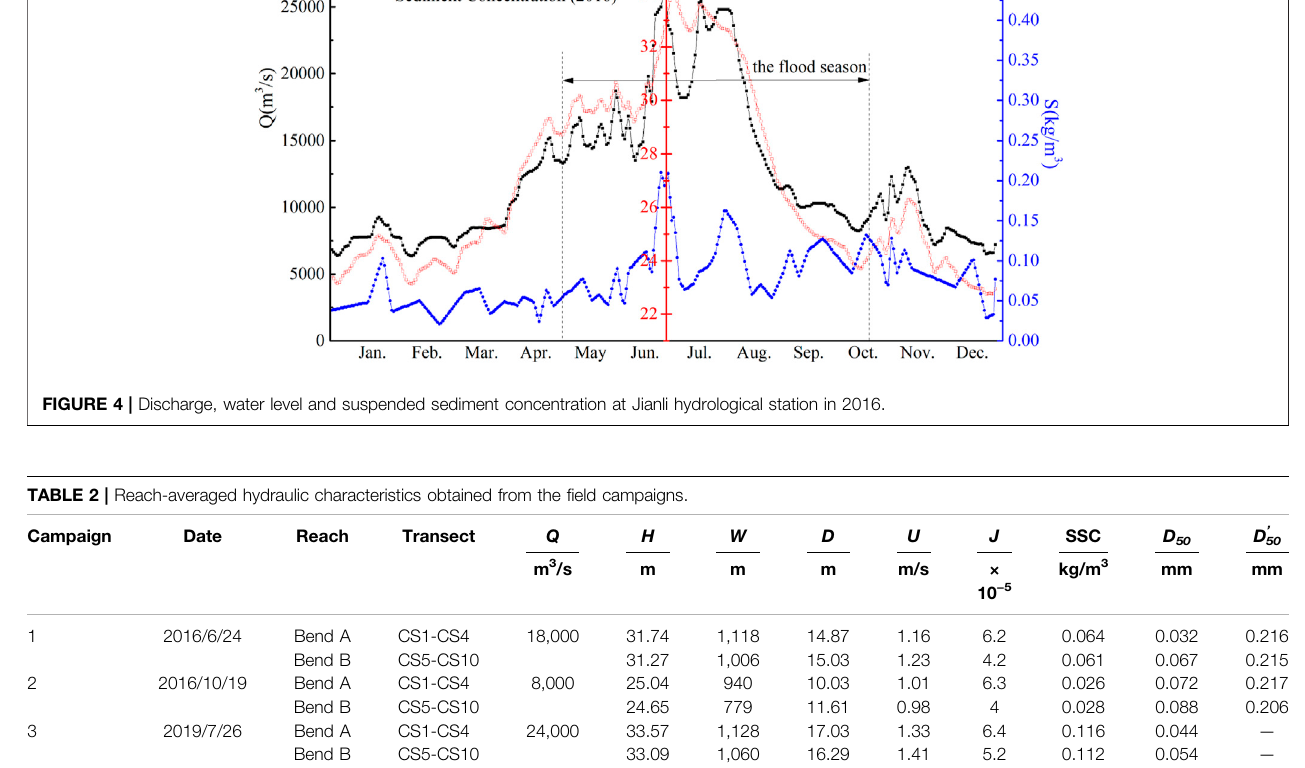
Frontiers in Earth Science |